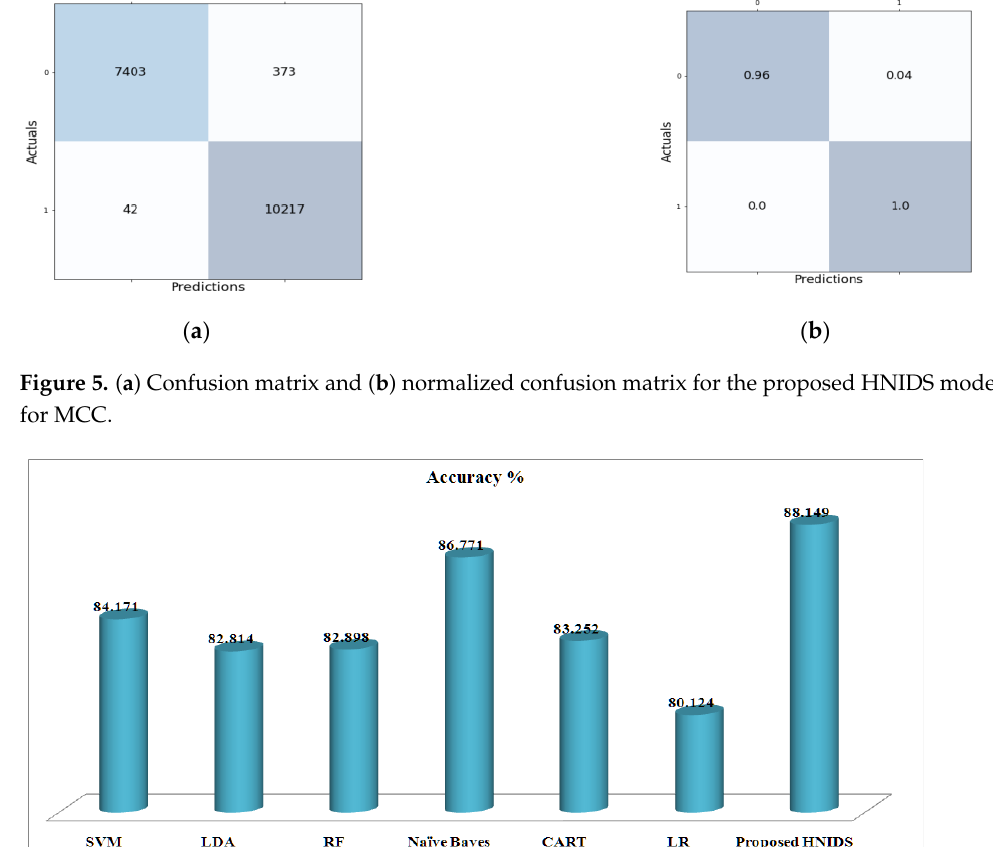
Figure 6. Accuracy % for proposed HNIDS model for MCC.